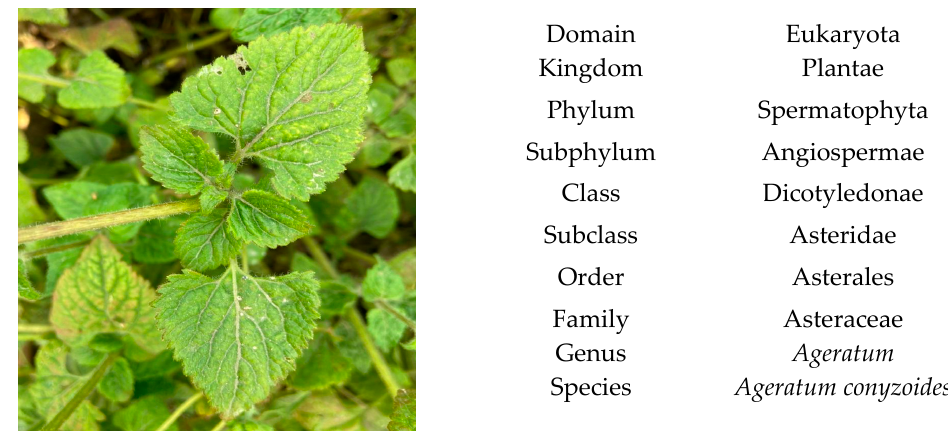
Figure 1. Ageratum conyzoides L. (Picture was taken in the month of April from the agricultural land in Jammu, India.).